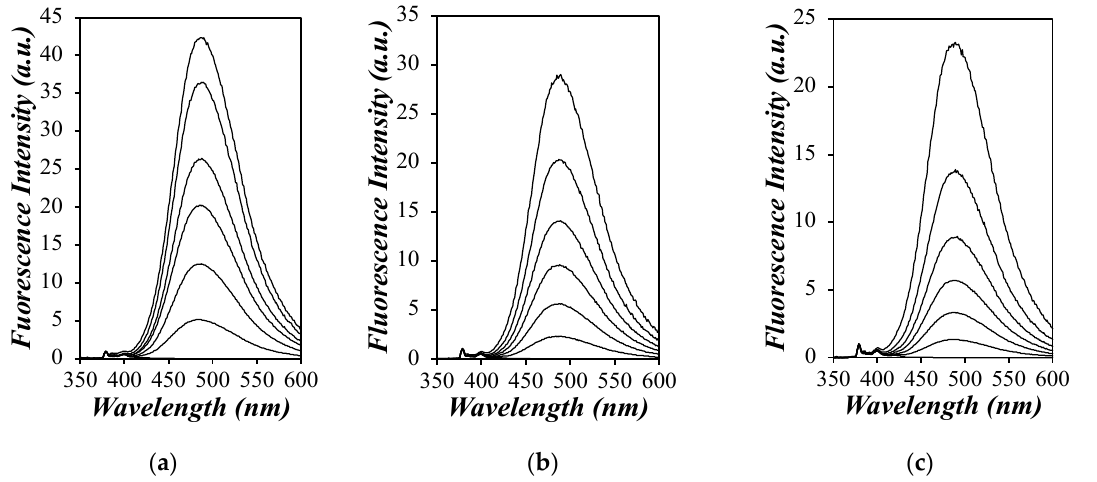
Figure 1. Steady-state fluorescence (SSF) spectra of the Py x -G( N ) dendrons normalized at the 0-0 transition of pyrene (~378 nm) in ( a ) toluene, ( b ) N , N -dimethylformamide (DMF), and ( c ) dimethylsulfoxide (DMSO). From top to bottom: Py 64 -G(6), Py 32 -G(5), Py 16 -G(4), Py 8 -G(3), Py 4 -G(2), and Py 2 -G(1). λ ex = 344 nm, [Py] = 2.5 × 10 − 6 M.